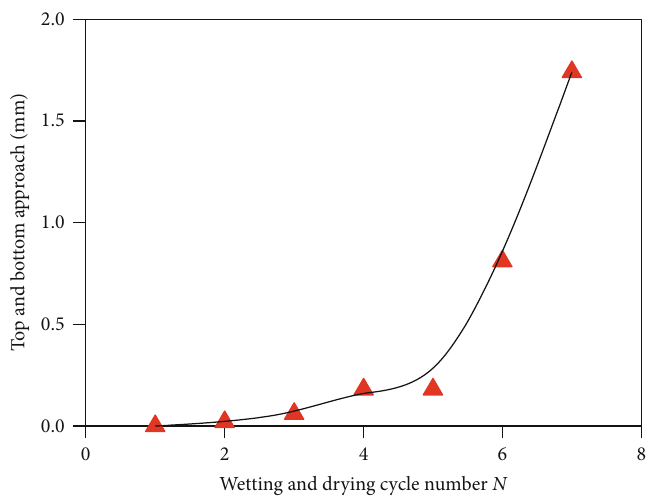
Figure 8: E ff ect of wetting-drying cycle number on a top and bottom approach of the tunnel surrounding